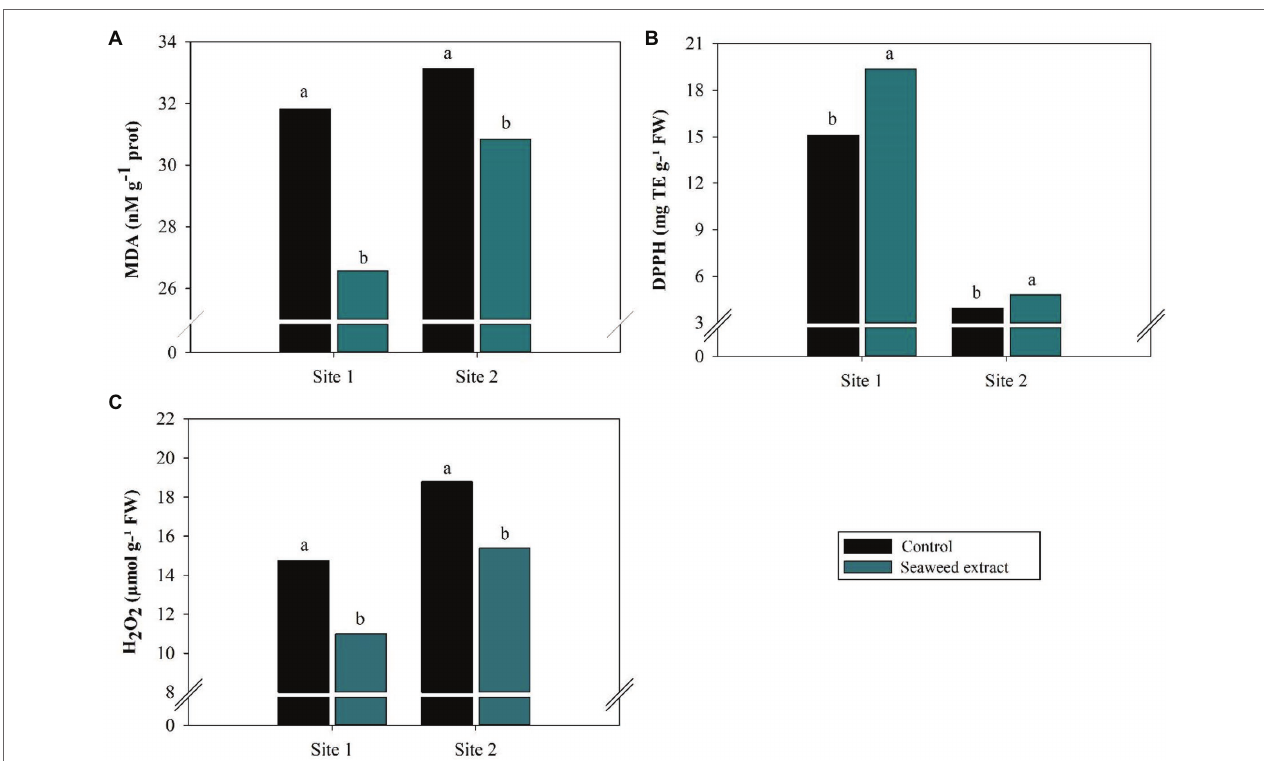
FIGURE 4 | Effects of seaweed extract (SWE) application on sugarcane reactive oxygen species (ROS) scavenging parameters at harvest: (A) MDA (nM g − 1 prot), (B) DPPH (mg trolox/100 g FW) and (C) H 2 O 2 ( μ mol g − 1 FW). The treatments were as follows: Control, no SWE application; Seaweed extract: application of SWE biostimulant based on Ascophyllum nodosum in the beginning of the drought season (July at site 1 and June at sites 2 and 3). Averages followed by the same letters do not differ by the LSD test ( p <